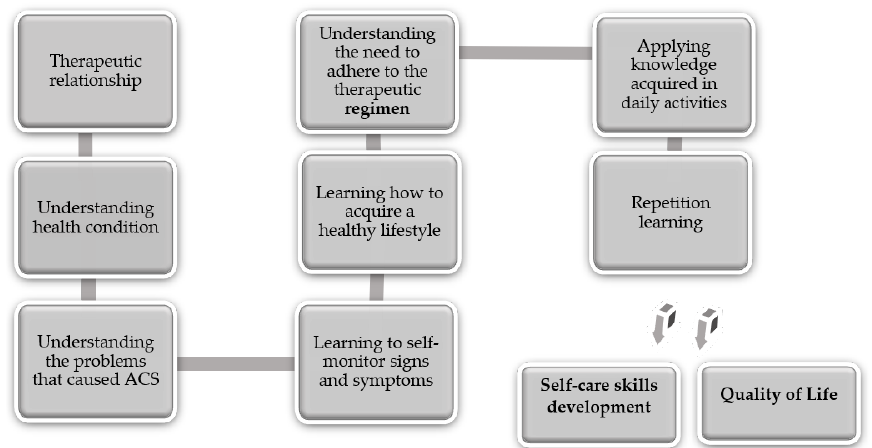
Figure 1. Educational intervention program framework and outcome indicators.